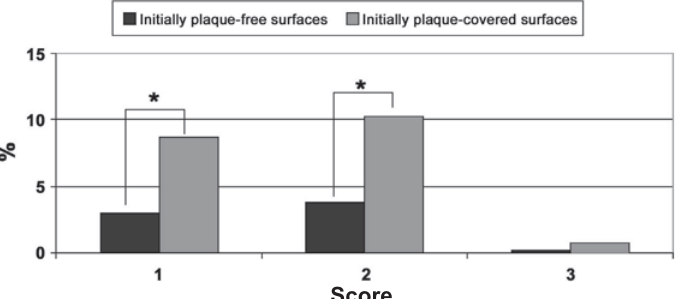
Figure 4- Frequency of sites with scores 1, 2 and 3 of stain extent on day